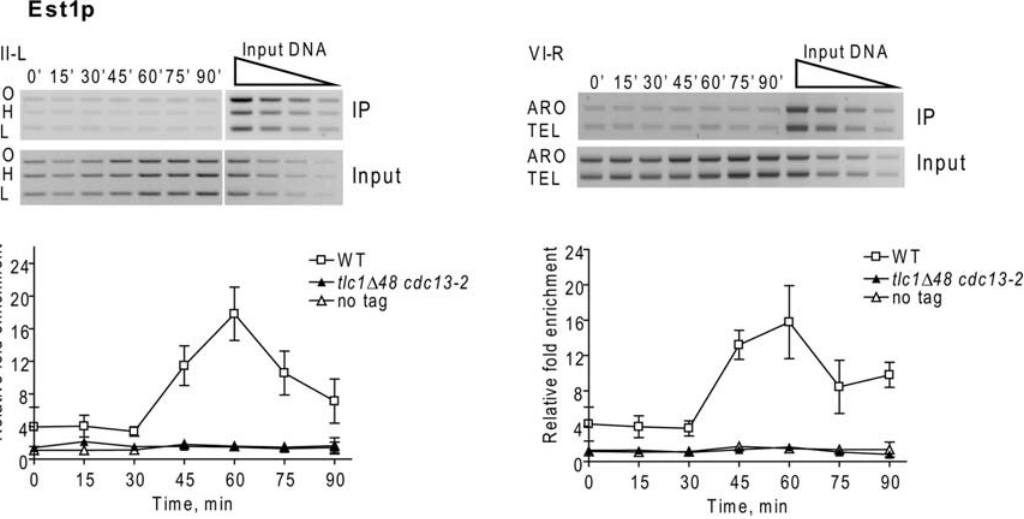
Figure 6. Est1p telomere binding is eliminated in mutants lacking both the G1 and the late S/G2 phase recruitment pathways. Methods are the same as in Figure 1 legend. Est1p binding to VII-L (left) or VI-R (right) telomeres in synchronous tlc1 D 48 cdc13-2 (black triangles) versus WT (white squares), or untagged (white triangles) cells. Est1p telomere binding in the double mutant tlc1 D 48 cdc13-2 was indistinguishable from the no-tag control at all time points at the VII-L telomere (P ranged from 0.12 to 0.98) except at 15 min (P=0.0007). Est1p binding in the double mutant was indistinguishable at the VI-R telomere (P values ranged from 0.38 to 0.64) except at 15 (P=0.0423) and 30 (P=0.0399) mins.